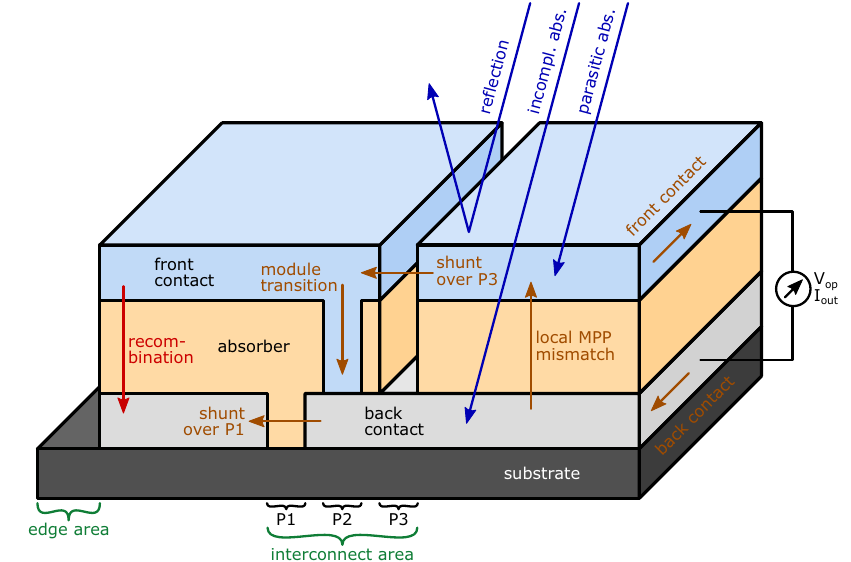
Fig. 5 Possible losses within a thin- fi lm solar module. The losses are divided into four categories. Re fl ection, parasitic absorption, and incomplete absorption form the optical part. Recombination mechanisms are within the electronic portion, while area losses represent the geometrical losses. Electrical losses can be classi fi ed into ohmic losses, shunts, and local maximum power point